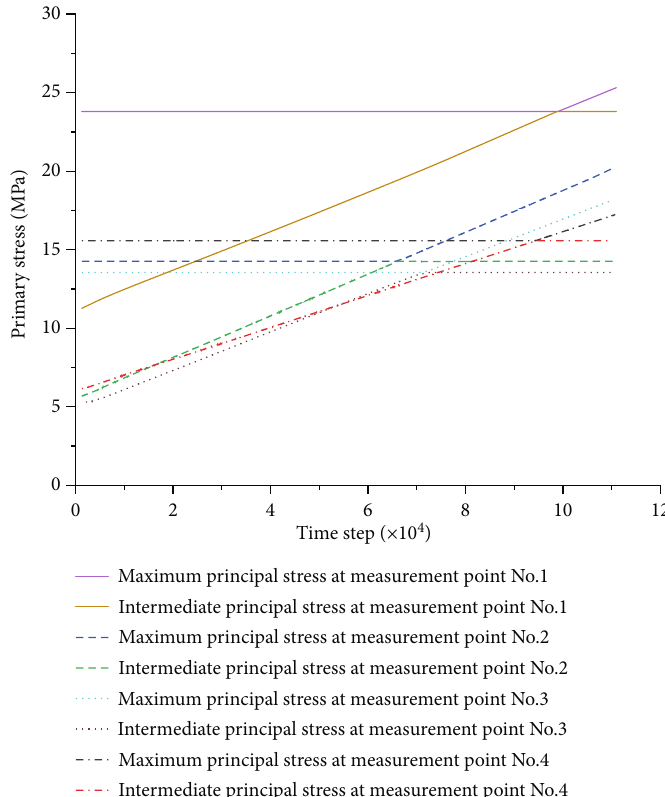
Figure 10: Stress variation curves of the measuring points.